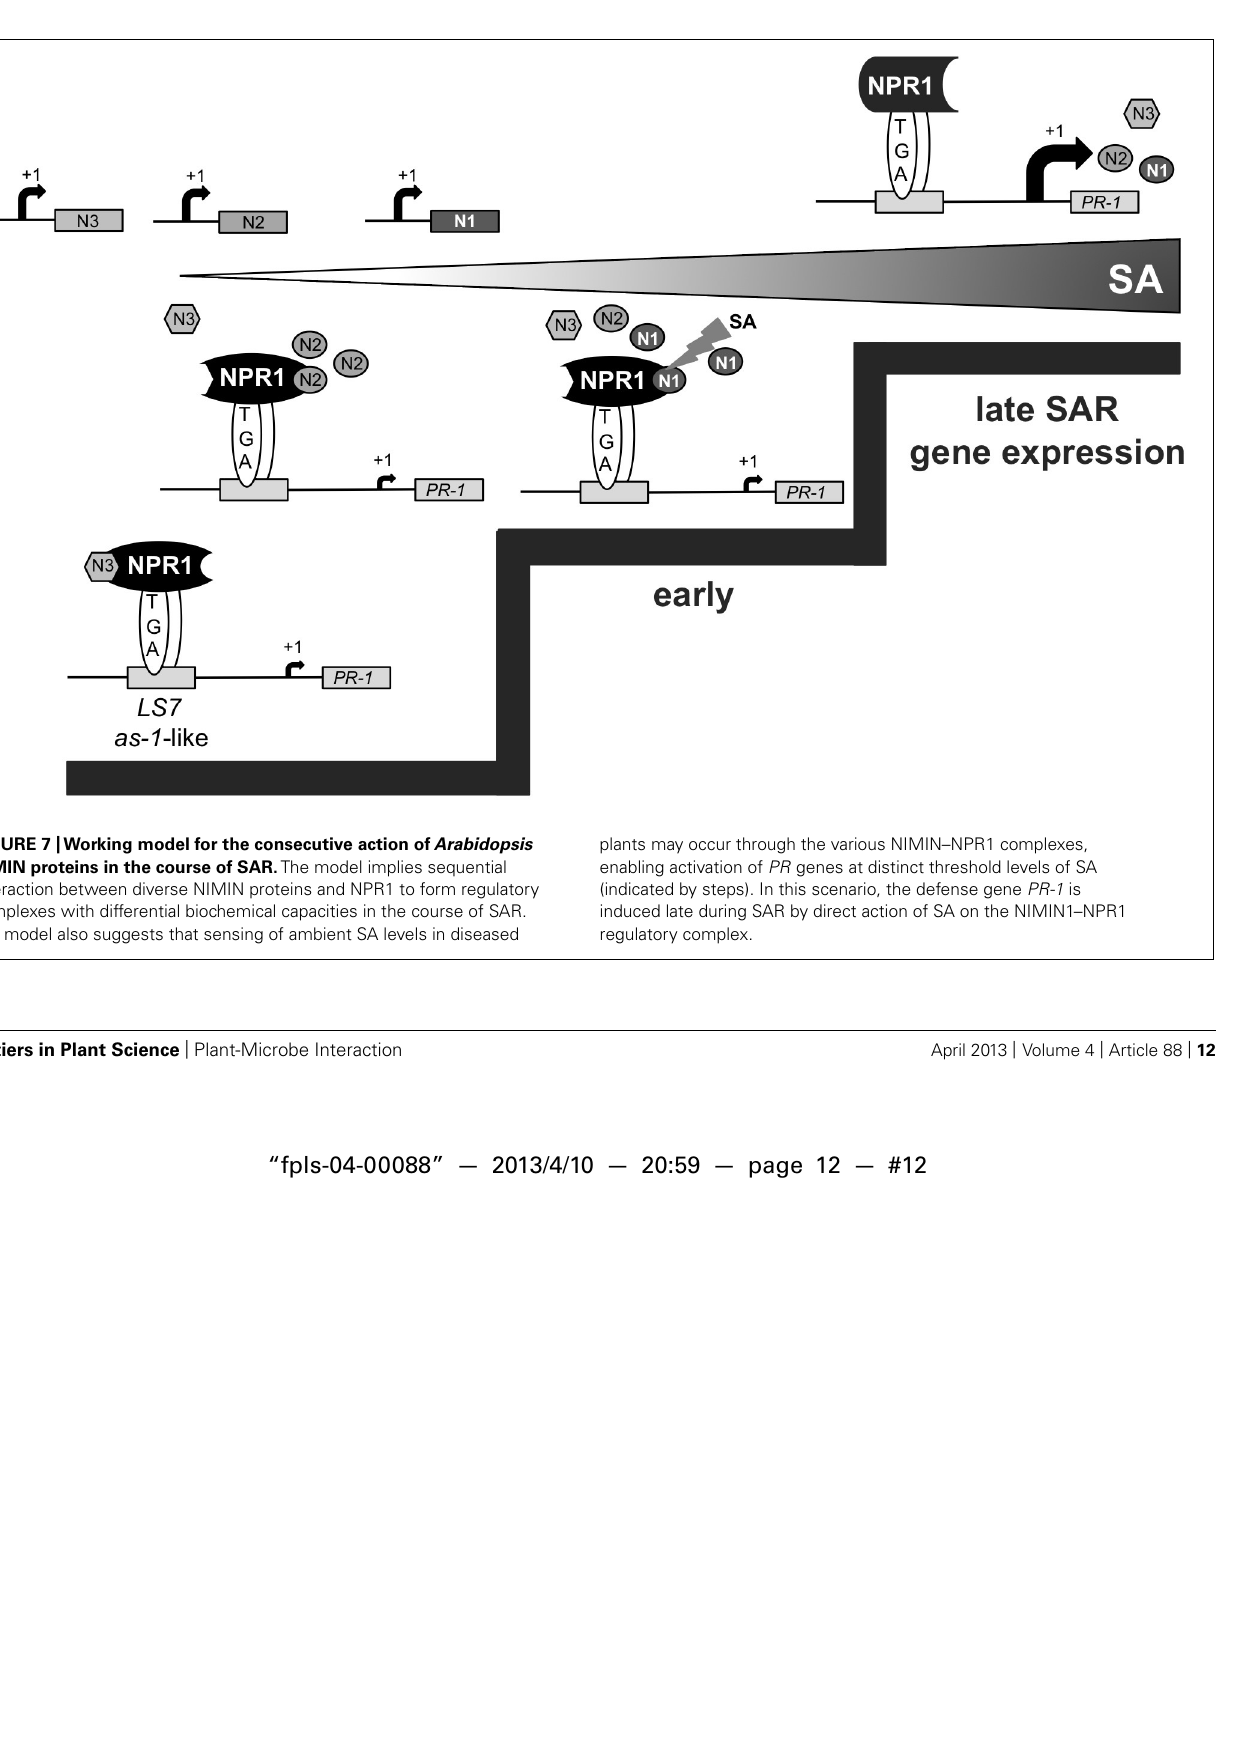
FIGURE 7 |Working model for the consecutive action of Arabidopsis NIMIN proteins in the course of SAR. The model implies sequential interaction between diverse NIMIN proteins and NPR1 to form regulatory complexes with differential biochemical capacities in the course of SAR. The model also suggests that sensing of ambient SA levels in diseased